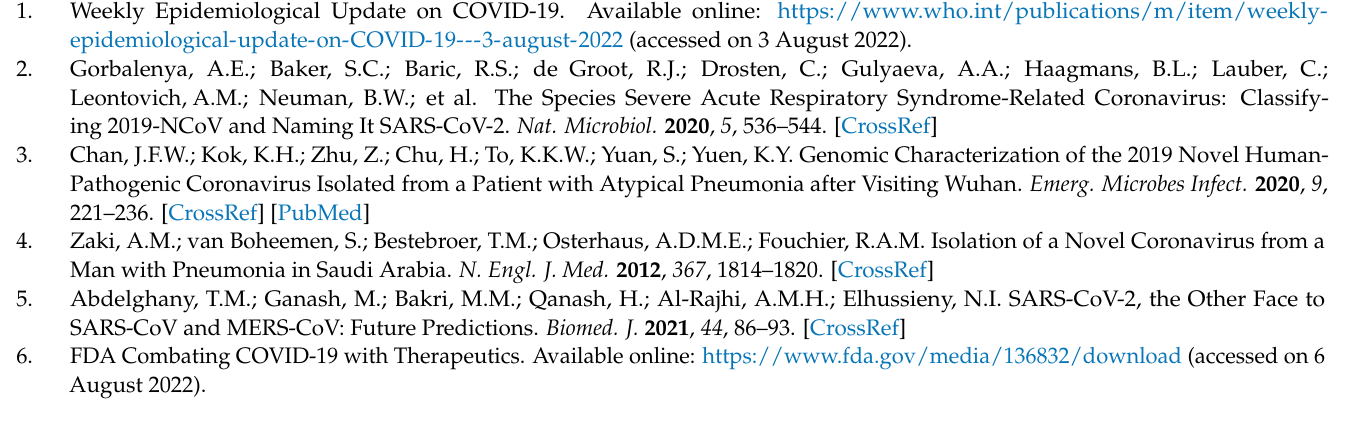
St. Georg Leipzig; Table S5: Clinical parameters of infected patients from Krankenhaus Nord- west; Table S6: Clinical parameters of negative control samples; Table S7: Raw data of analyti- cal sensitivity; Table S8: Raw data of precision and reproducibility; Figure S1: Optimization of the spike-protein ELISA; Figure S2: Linearity of the spike-protein ELISA; Figure S3: Interference; Figure S4: Cross-reactivity; Figure S5: Accelerate stability of spike-protein ELISA; Figure S6: Com- parison of spike-protein and nucleocapsid-protein